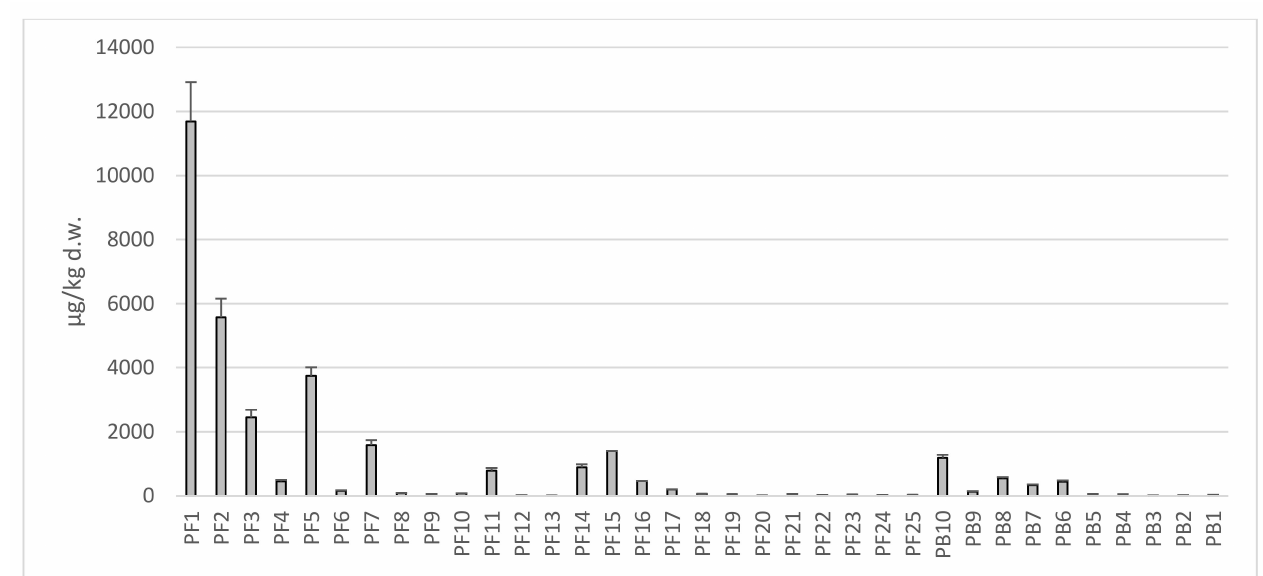
Figure 2. Concentration of Σ 16PAH at the sampling sites (bars are standard